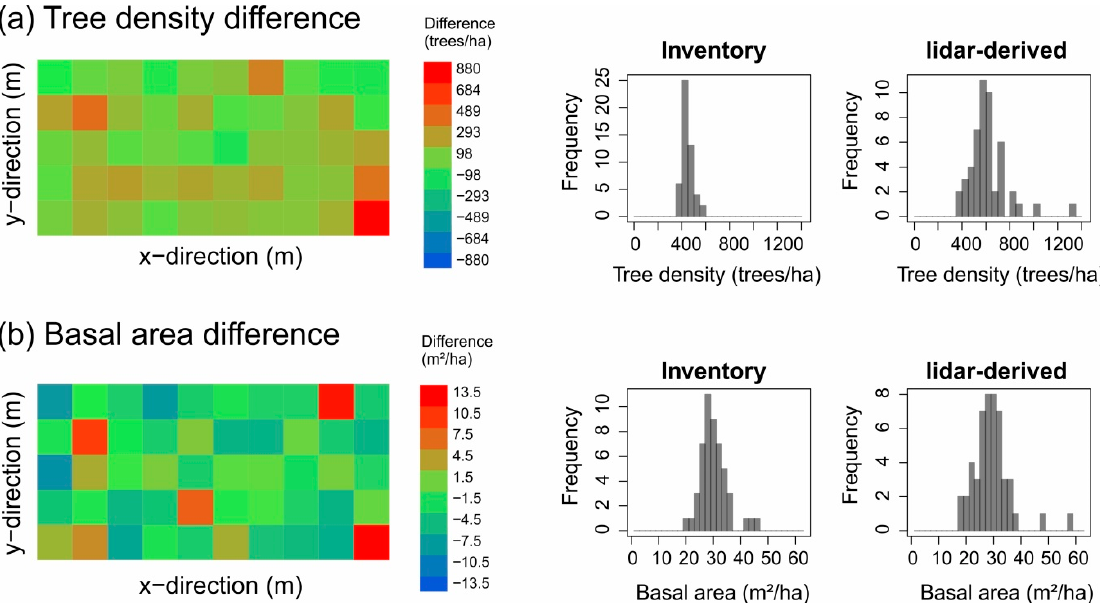
Figure A5. Spatial maps of the difference in ( a ) tree density (trees/ha) and ( b ) basal area (m²/ha) between lidar and inventory and respective histograms on the example of the 1-ha scale. Green colors denote the optimal values. Table A3. Correlation coefficients (Spearman’s r ) of R ² values (of the compared lidar-derived and inventoried stem diameter distribution) correlated with other statistical measures, lidar data measures, and forest structure attributes for different plot sizes (1, 0.25, and 0.04 ha). See methods and Table 1 for details.